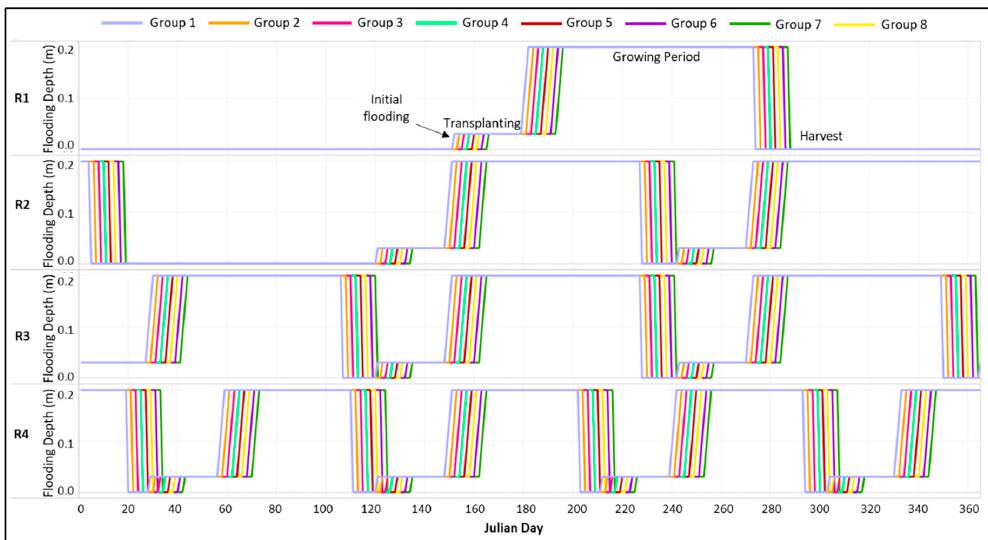
Figure A1. Rice irrigation schedule for four rice planting schedules in the 8 irrigation groups.